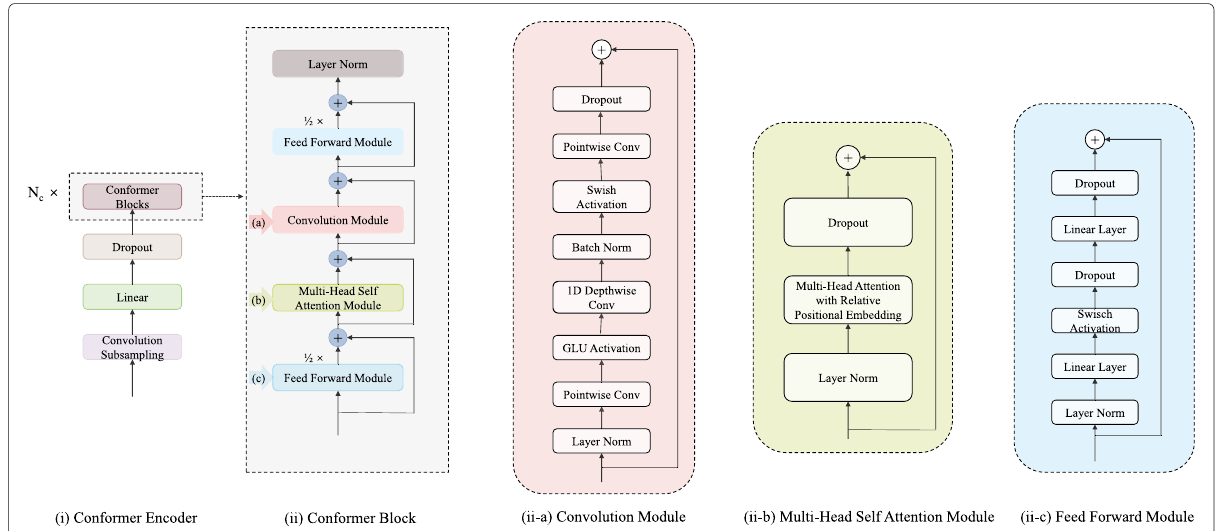
Fig. 5 Illustration of the Conformer encoder model architecture. i Conformer encoder architecture. ii Conformer block architecture. ii-a Convolution module of the Conformer block. ii-b Multi-headed self-attention module of Conformer block. ii-c Feed forward module of Conformer